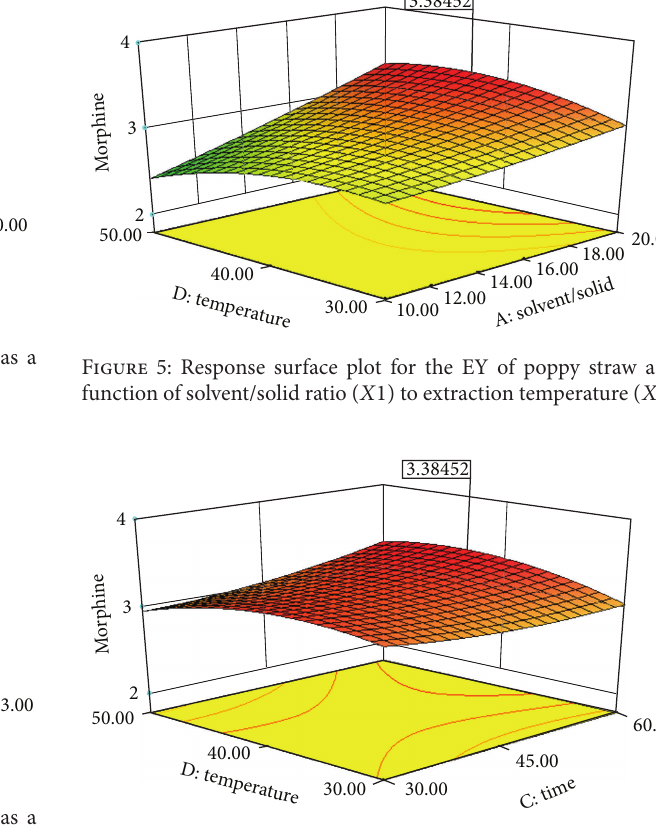
Figure 6: Response surface plot for the EY of poppy straw as a function of extraction time ( 𝑋3 ) to extraction temperature ( 𝑋4 ).